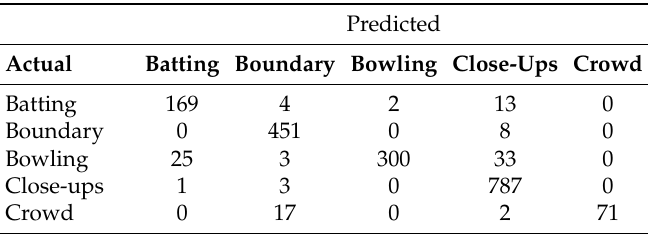
Table 5. Confusion matrix Minhas et al. [1].